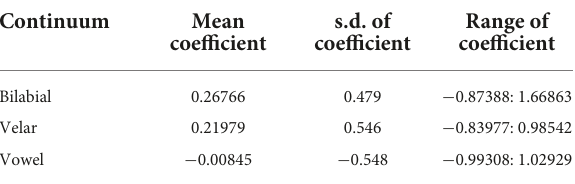
TABLE 5 Summary of the individual models computed for the participants. Continuum Mean